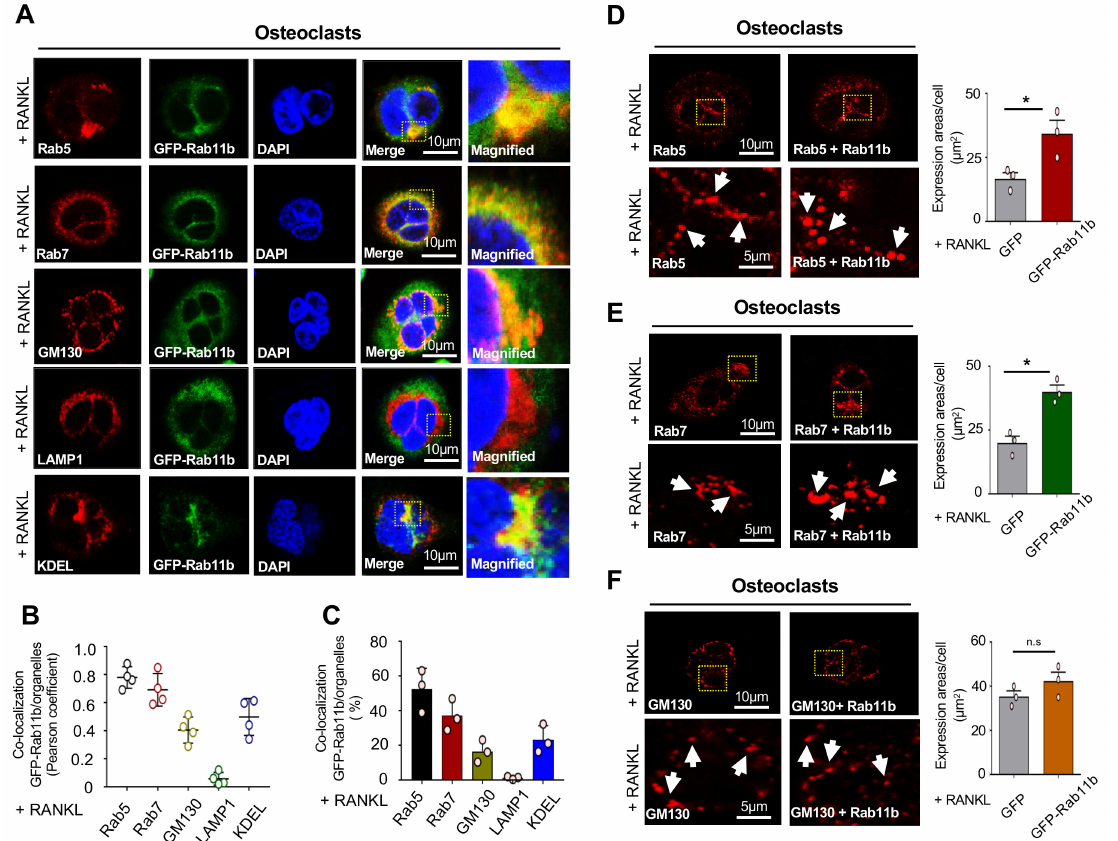
Figure 5. Subcellular localization of Rab11b in RAW-D cell-derived osteoclasts, and the e ff ects of Rab11b overexpression on size-based modification of organelles. ( A ) The osteoclasts derived from RAW-D cells stably expressing GFP-Rab11b (clone #1) (green) were seeded on cover glasses with fixation and permeabilization of 0.2% Triton X-100 in PBS, and subsequently reacted with one of the antibodies against Rab5, Rab7, MG130, LAMP1, or KDEL (red, as indicated) that are specific markers for early endosomes, late endosomes, Golgi complex, lysosomes, or endoplasmic reticulum, respectively. Osteoclast DNA was stained with 4 (cid:48) ,6-diamidino-2-phenylindole (DAPI) (blue). Specific regions of interest within a field are shown by yellow boxes in a magnified form on the left-hand top of each image it was taken from. Specific regions of interest within a field, designated by yellow boxes, are magnified on the right side of each image it was taken from. Mean ± SD of three independent repeats. Scale bar: 10 µ m. ( B , C ) GFP-Rab11b co-localization with Rab5, Rab7, MG130, LAMP1 and KDEL was determined and evaluated by Pearson coe ffi cient ( B ) or by color threshold analysis ( C ) using Fiji / ImageJ on at least 4 cells. ( D – F ) RAW-D cells stably expressing GFP or GFP-Rab11b were fixed and permeabilized with 0.2% Triton X-100, and stained with the specific antibodies to detect ( D ) Rab5 (red), ( E ) Rab7 (red), and ( F ) MG130 (red). The images were captured by confocal laser microscopy. The particle size was measured by ( µ m 2 ) using ImageJ (shown on the right side). Mean ± SD of at least four independent repeats. * p < 0.05, n.s., nonsignificant (Student’s t